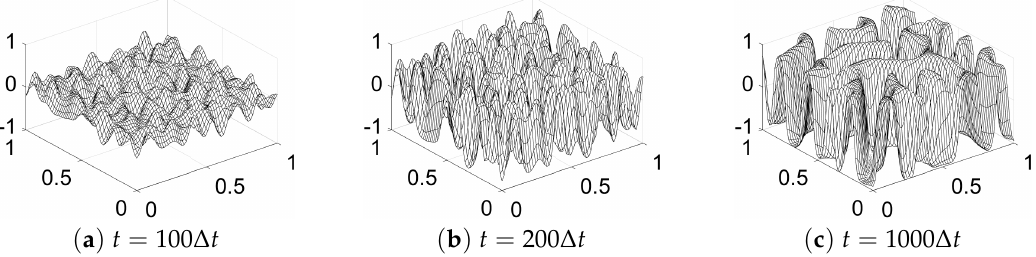
Figure 5. Snapshots of the phase-field φ at ( a ) t = 100 ∆ t , ( b ) t = 200 ∆ t and ( c ) t = 1000 ∆ t . Here, (cid:101) = (cid:101) 4 , h = 1/64 and ∆ t = 0.1 h 2 are used.